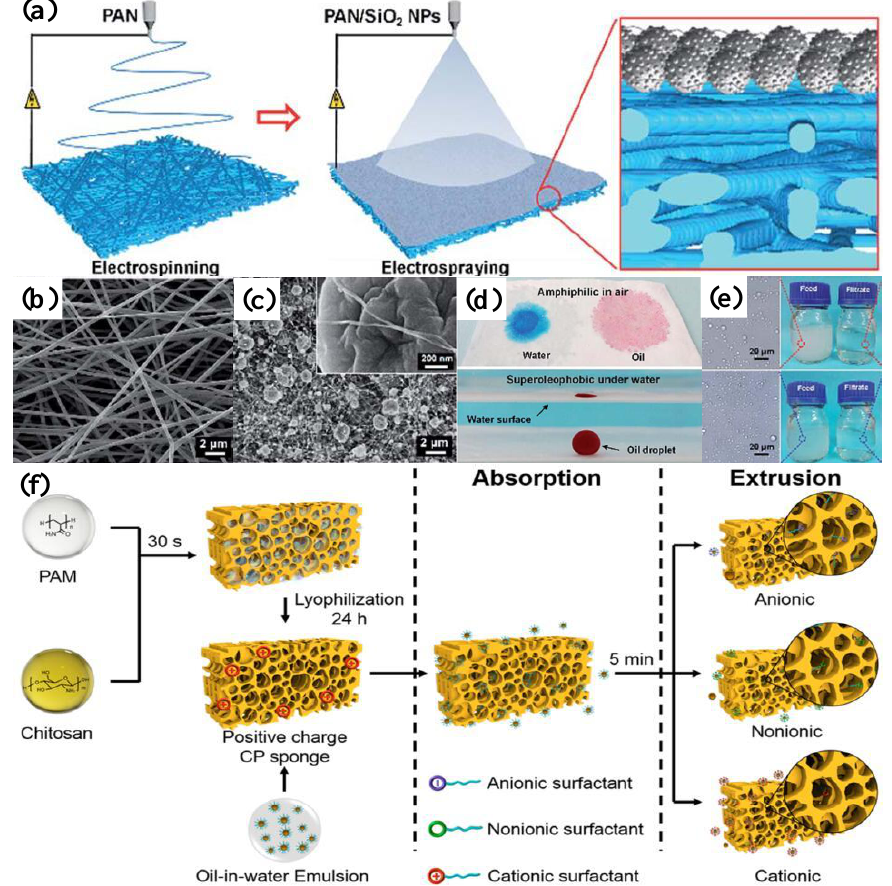
Figure 9. ( a ) Illustration of electrospinning PAN nanofibers/SiO 2 nanoparticles with hierarchical structures [141], ( b ) a morphology of PAN nanofibers via electrospinning [141], ( c ) SiO 2 nanoparticle-coated PAN nanofibers with hierarchical structure [141], ( d ) superhydrophilicity and underwater superoleophobicity [141], ( e ) highly efficient oil/water emulsion separation [141], reproduced with permission from the Royal Society of Chemistry. ( f ) Illustration of